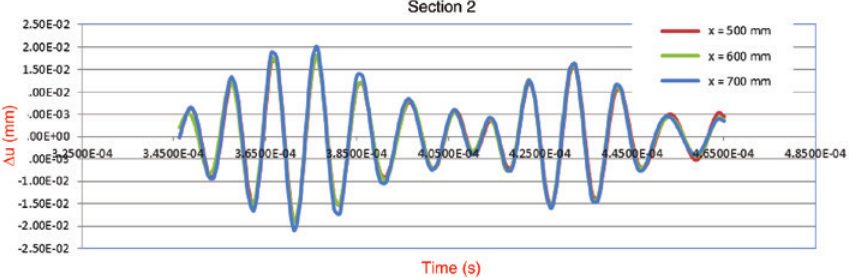
Figure 22: Time domain response at Section 2 with varying damage